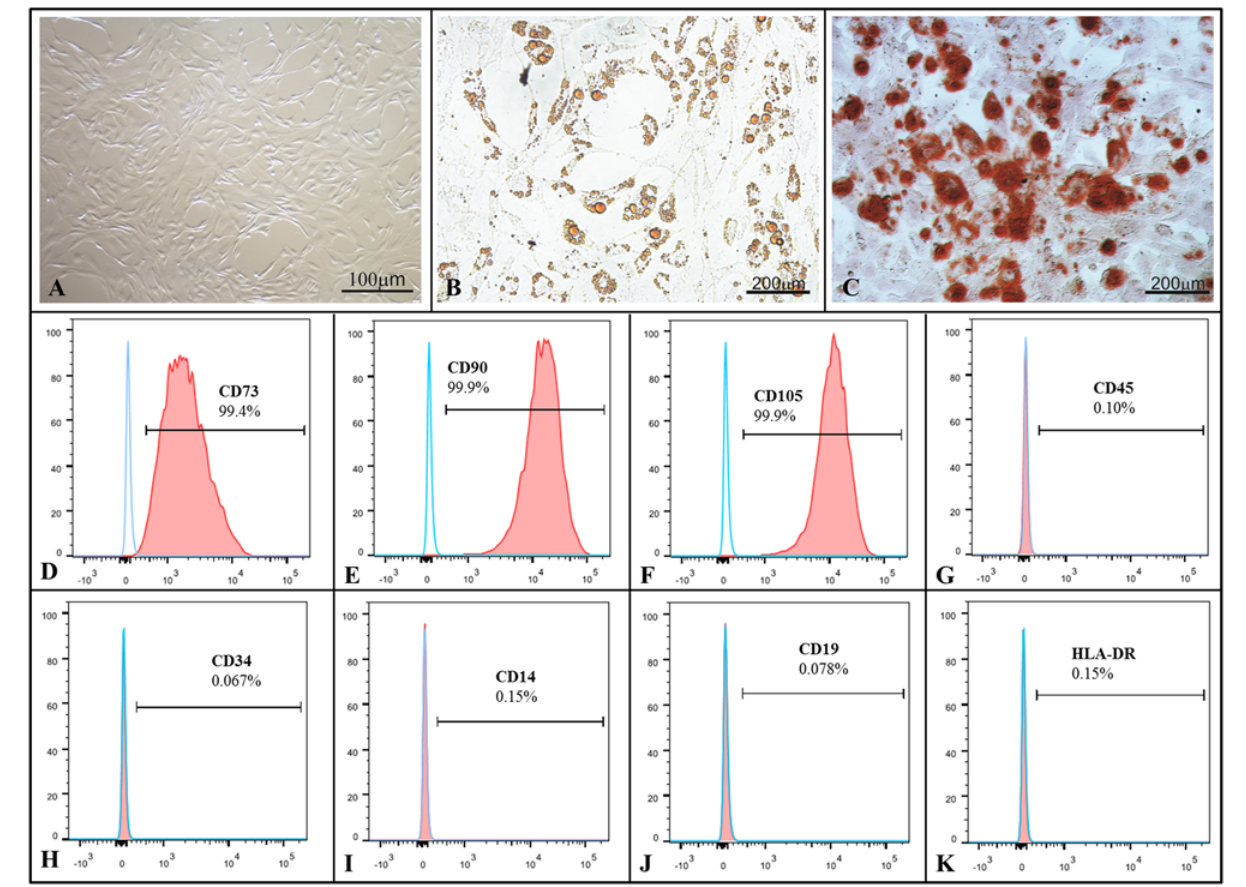
Fig 1. MSC characterization. Human chorionic-derived stem cells exhibit a fibroblast-like cell shape (A) and showed successful adipogenic (B) and osteogenic (C) differentiation potential, presenting a positive signal for (D-F) CD73, CD90 and CD105 and no signal for (G-K) CD45, CD34, CD14, CD19 and HLA-DR markers ( n =